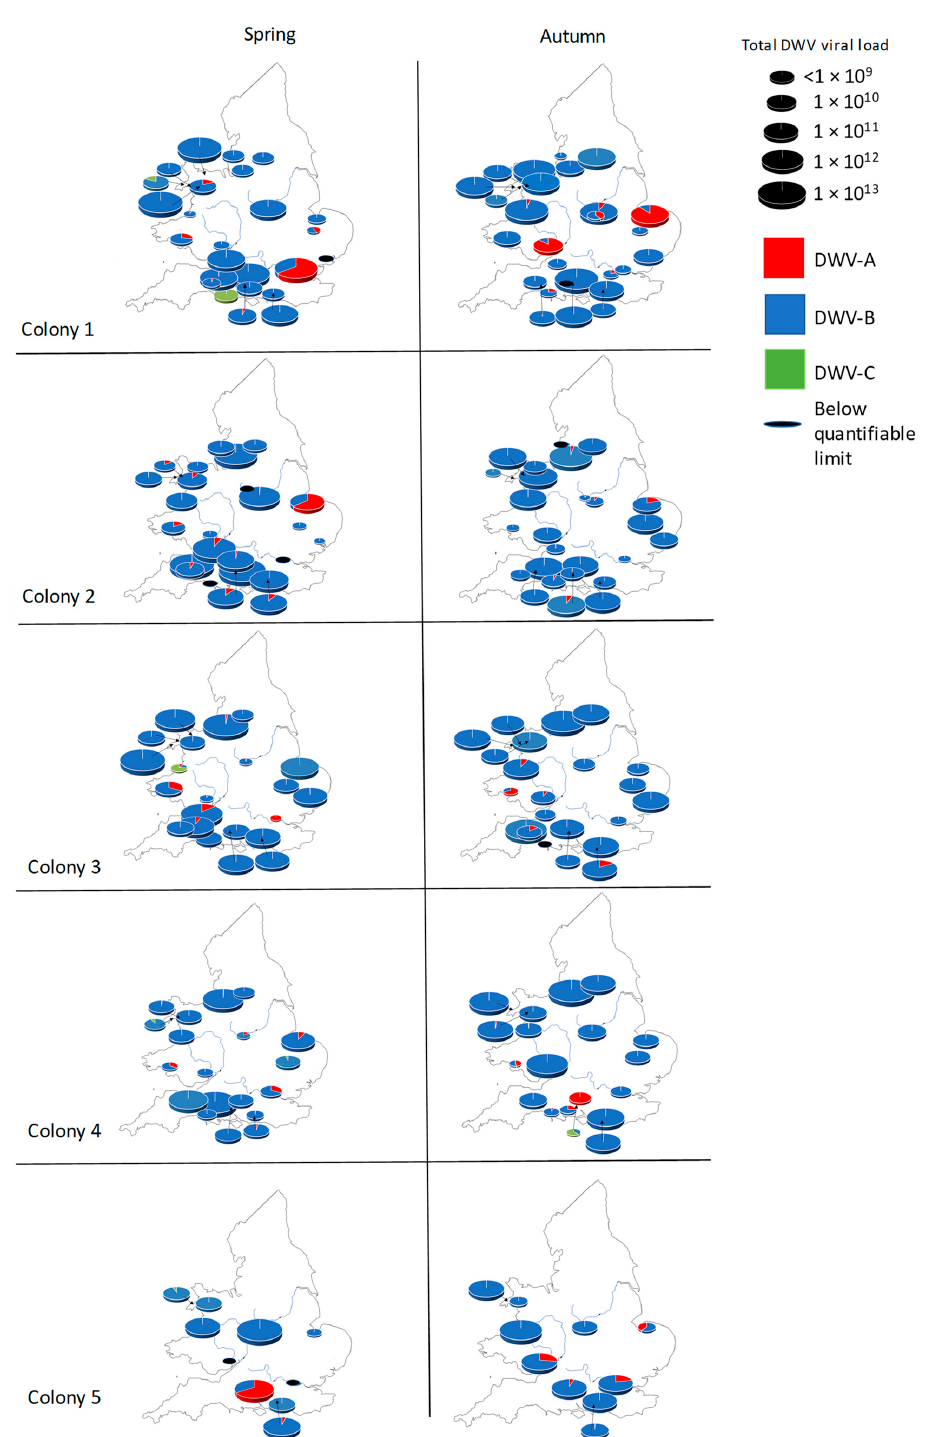
Figure 2. DWV variant prevalence and abundance in corresponding English and Welsh colonies, per season. Pie charts are representative of each colony sampled per apiary. The same colonies were sampled in spring and autumn. The size of the pie chart is relative to total DWV load per colony.